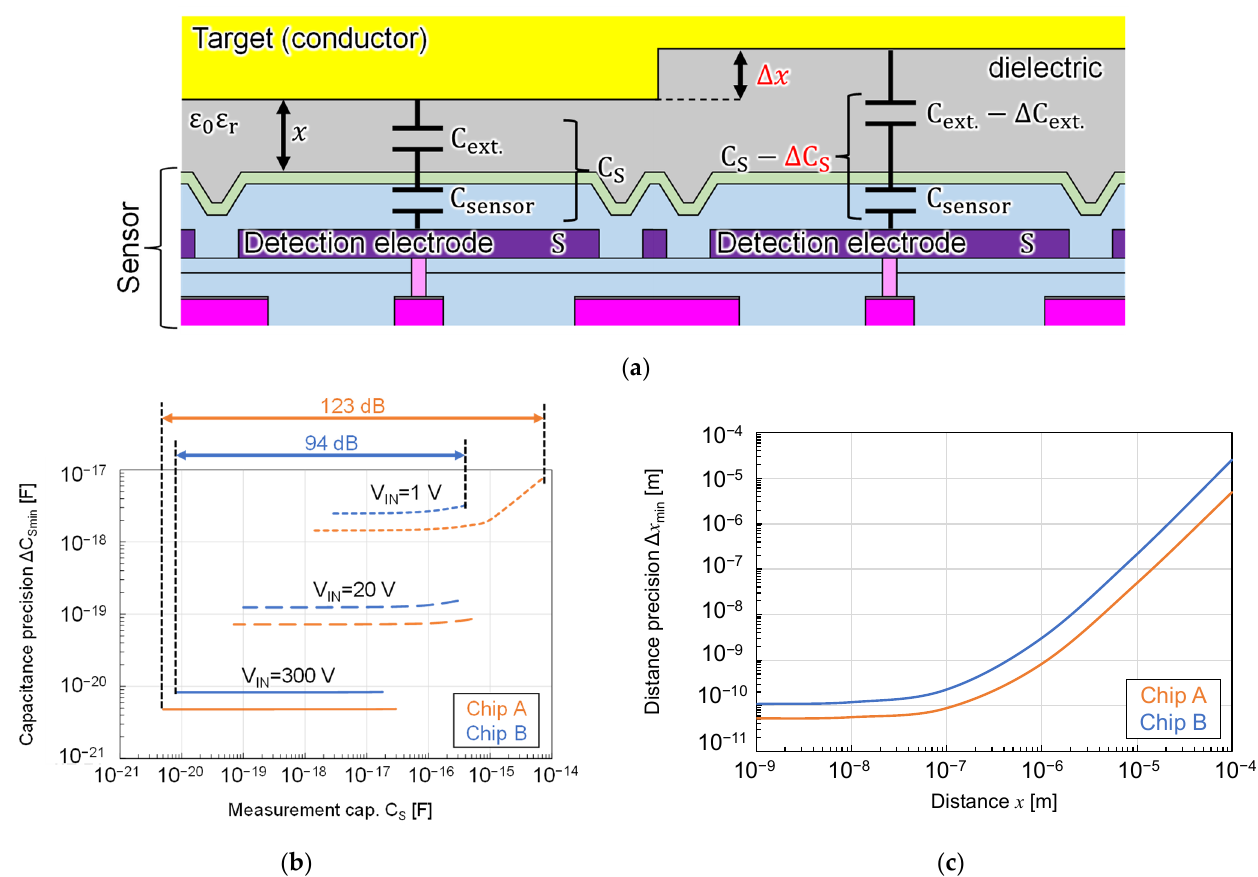
Figure 12. Calculation of capacitance and distance detection precision: ( a ) cross-sectional schematic diagram of a chip surface and a conductor target with small irregularities; ( b ) calculation results of the relation between the measurement capacitance C S and the capacitance detection precision ΔC Smin at each input voltage V IN ; ( c ) relation between the reference distance x between the chip surface and the target and the distance detection precision Δx min .